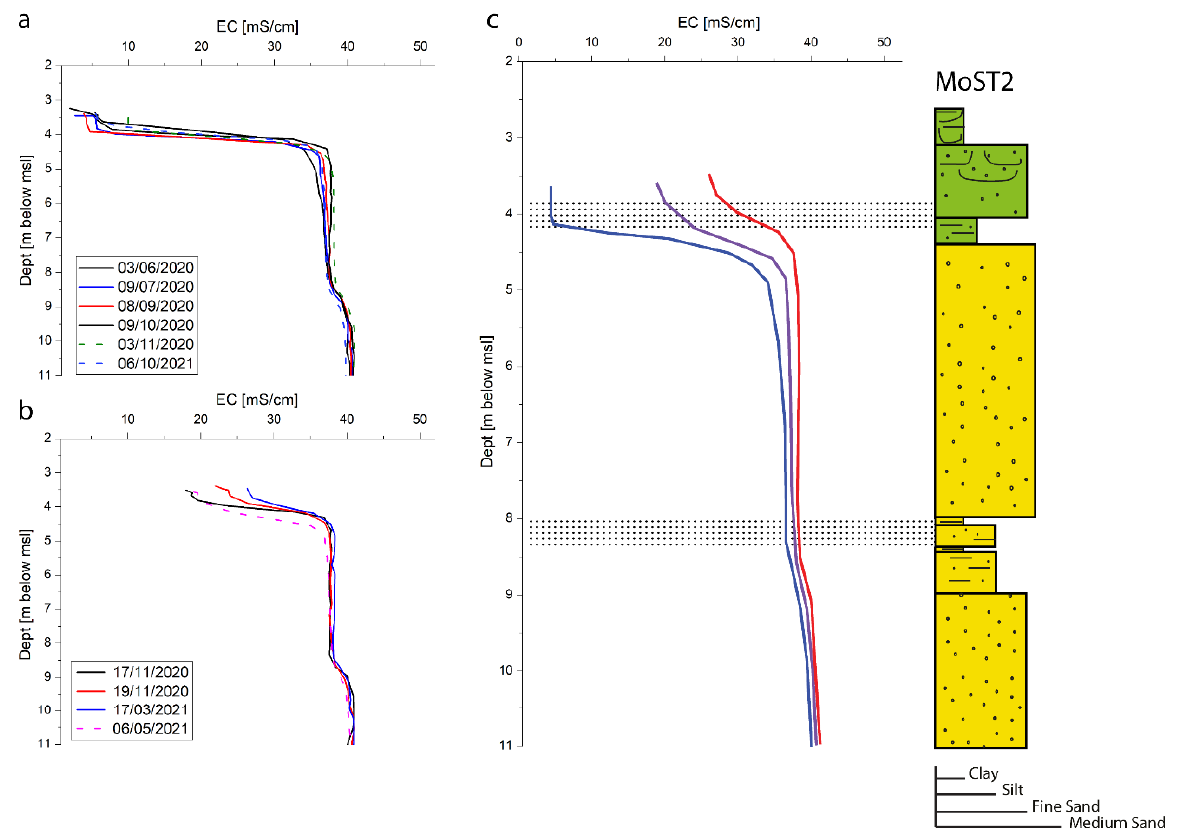
Figure 7. EC profiles collected in MoST2 well. Panels ( a , b ) show the configurations assumed by the EC curve during the observed period. The model of panel ( c ) summarizes the configurations and compares them with the stratigraphic section, outlining the sedimentary constraints (dotted areas) existing in the subsoil surrounding the monitoring point.